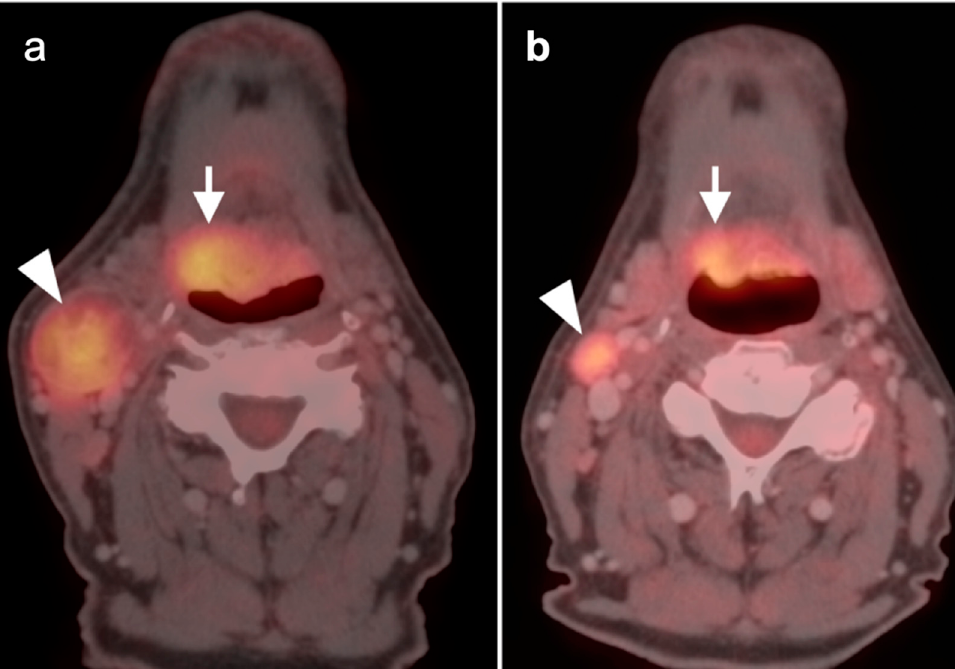
Figure 4. Incomplete response to treatment. Axial fused FDG PET-CT images before ( a ) and after ( b ) chemoradiation therapy demonstrate a right base of tongue squamous cell carcinoma (arrow) and ipsilateral right cervical pathological lymph node (arrowhead) with decreased, but still pathologic in both size and activity, after therapy. Table 2. NI-RADS criteria for reporting head and neck cancer primary site response to therapy or post-treatment surveillance by FDG PET-CT. Imaging findings, likely clinical significance and suggestions for further management are included